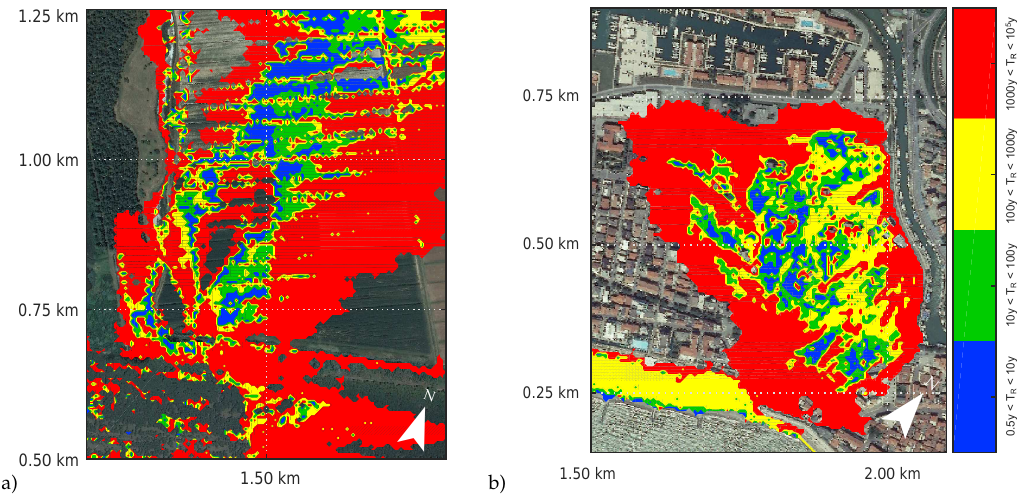
Figure 11. ( a ) Zoom of the Valle Vecchia hazard map shown in Figure 10; and ( b ) zoom of the Caorle hazard map shown in Figure